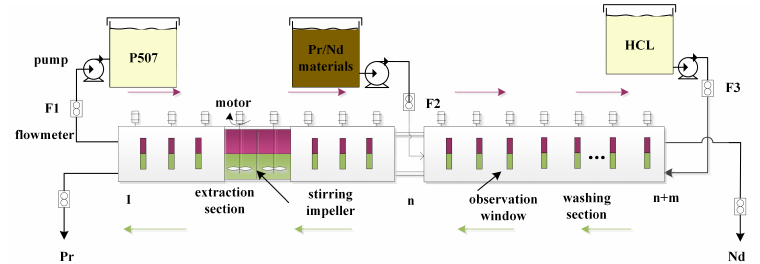
Figure 2. Schematic Diagram of Rare Earth Extraction Process.